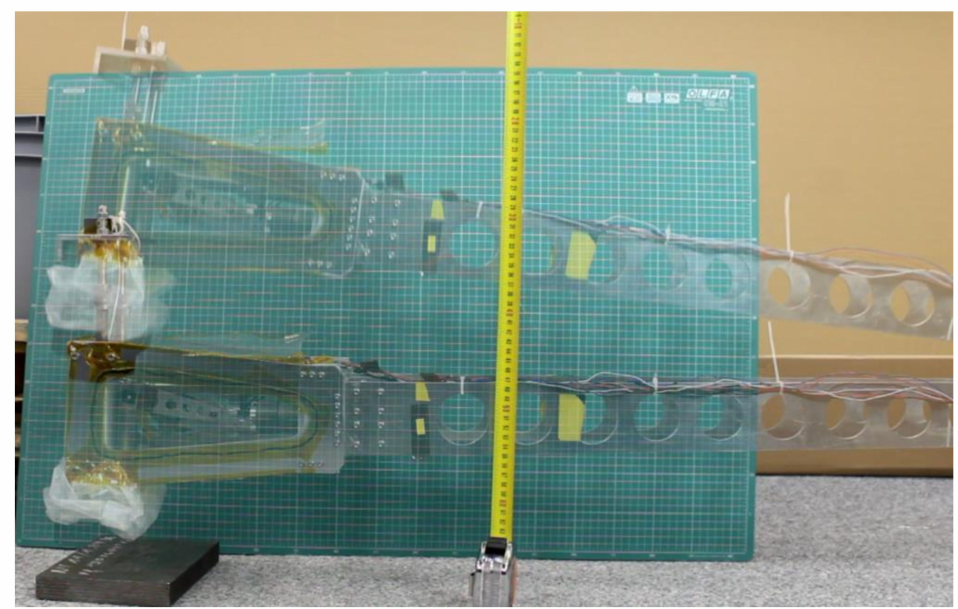
Figure 11. Two overlayed video frames showing actuating leg just before the jump and in the utmost height position ( h max